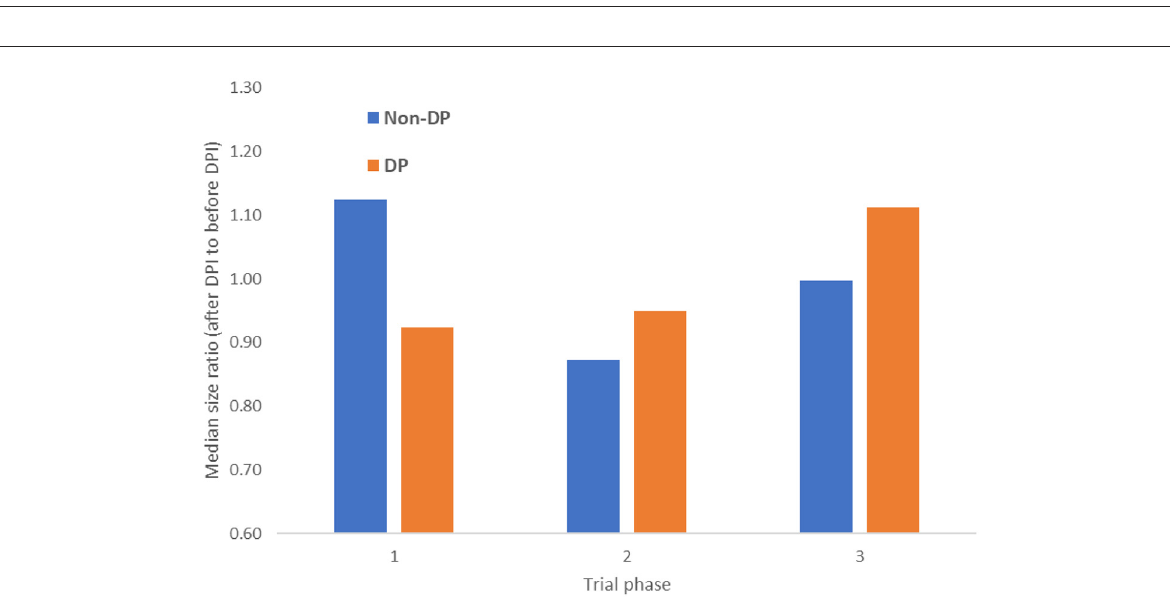
FIGURE4 Change in the number of trial participants after DPI date by trial phase and DP